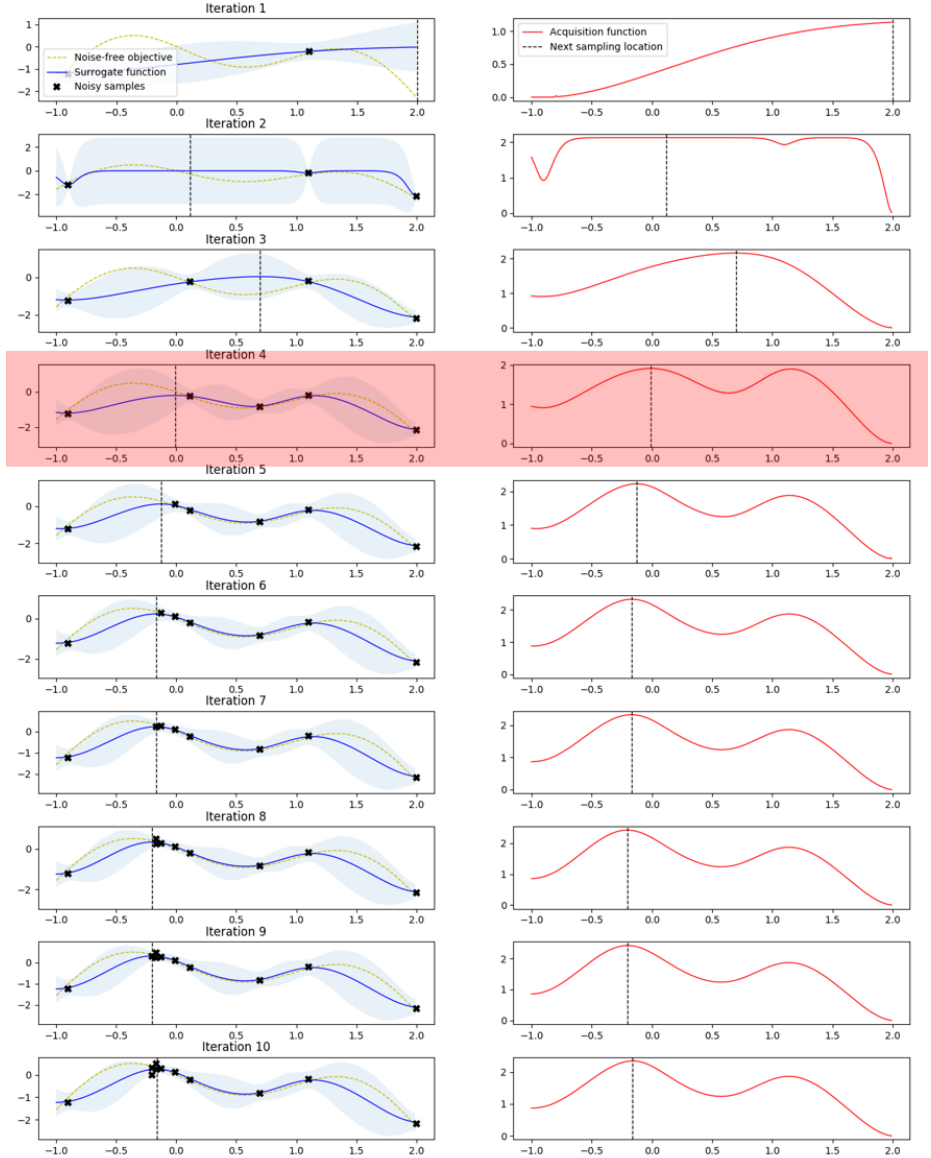
Figure 6. Tested of Gaussian process with Gamma